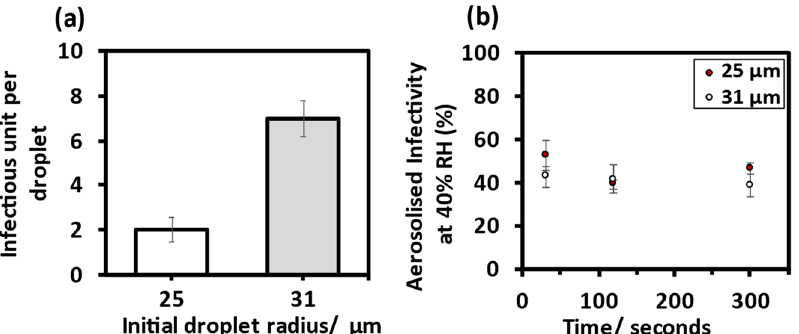
Figure 3. Comparing MHV infectivity in two droplet sizes. ( a ) Mean infectious unit per droplet for initial droplet radii at 90% RH and after 5 s levitations, 25 ± 1 µm (M = 2.01, SD = 1.54) and 31 ± 1 µm, (M = 6.97, SD = 2.46). ( b ) Collected virus infectivity over five minutes at 40% RH, for initial droplet radii 25 ± 1 µm and 31 ± 1 µm.